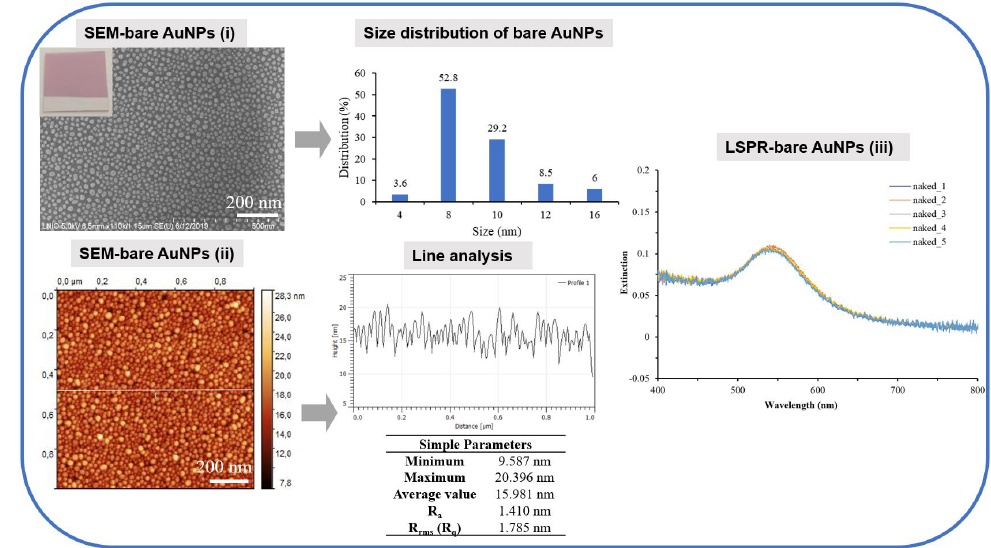
Figure 3. SEM ( i ), atomic force microscope (AFM) ( ii ) and LSPR ( iii ) characterizations of annealed gold nanostructured (AuNPs) coverslips. The size distribution of AuNPs (based on SEM image) and line profile analysis (based on AFM images) are also presented in the middle panel. The SEM, AFM and LSPR measurements were performed under cleanroom conditions at 21 °C.